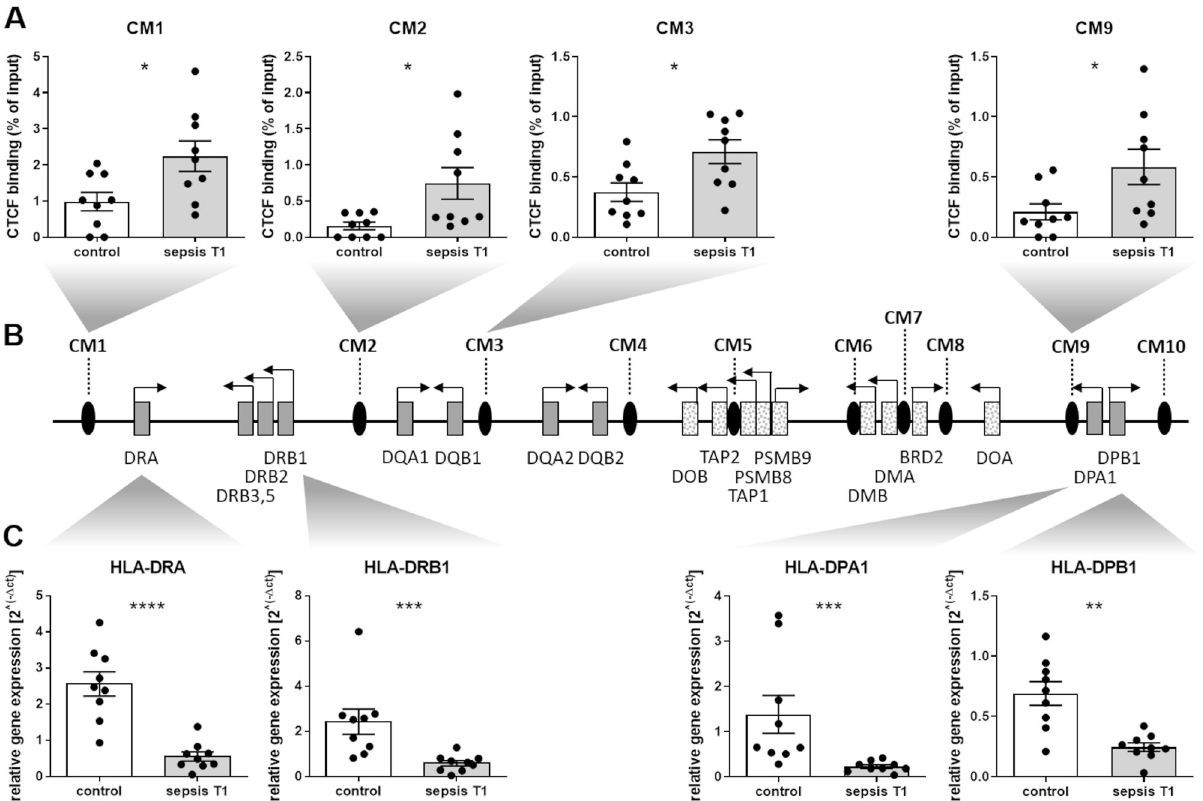
Fig 5. CTCF occupancy at specific binding sites within the MHC-II region and differential expression of classical HLA genes. (A) Chromatin from isolated human CD14 ++ monocytes (control patients and sepsis patients at the time of sepsis diagnosis, T1) was immunoprecipitated with anti-CTCF antibody for subsequent qPCR using primer pairs on specific target regions within the MHC-II region identified by Majumder and Boss [22]. Enrichment of CTCF at the binding sites CM1, CM2, CM3 and CM9 is shown (p < 0.05, Mann-Whitney U test, control patients n = 9, patients with sepsis n = 9, mean ± SEM). (B) Schematic diagram of human chromosome 6p21.3 showing the relative positions of CTCF binding sites (black ovals) and MHC-II genes (boxes, classical HLA genes are shown as filled boxes). (C) RNA from isolated human CD14 + monocytes was used for